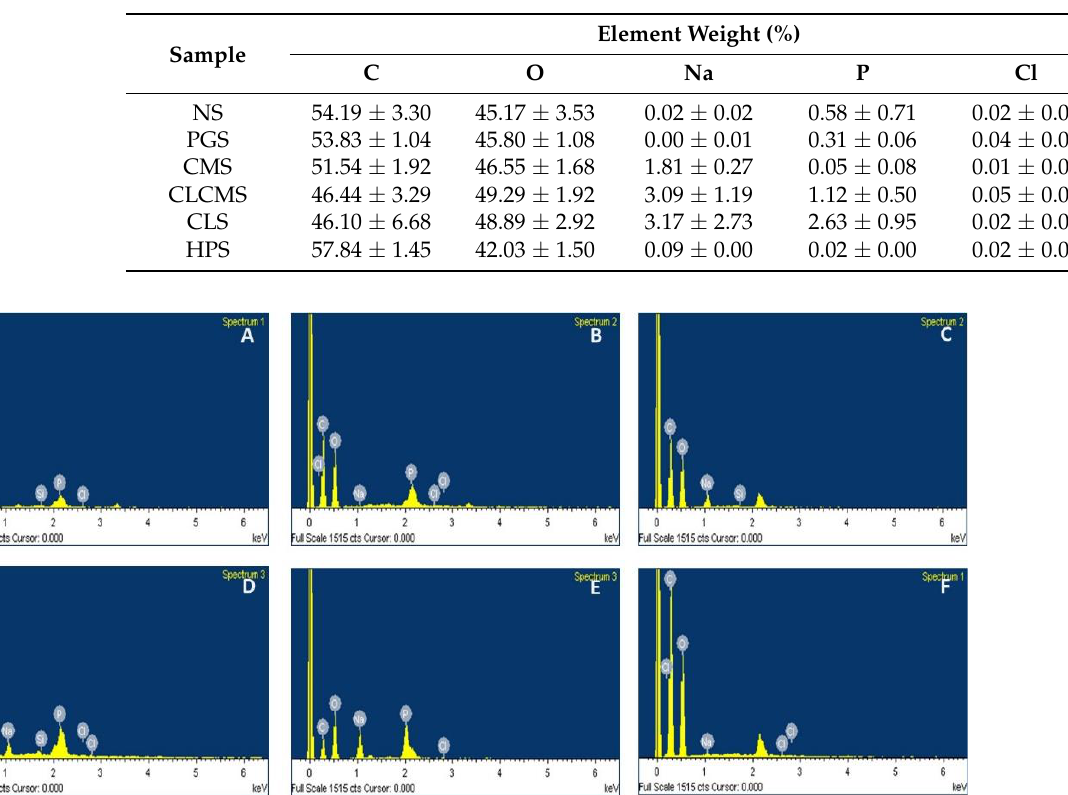
Figure 3. EDX Spectra of ( A ) NS, ( B ) PGS, ( C ) CMS, ( D ) CLCMS, ( E ) CLS, and ( F ) HPS Modified from KJ CMU-107 Rice Starch. Table 1. Energy-dispersive X-ray (EDX) Analysis of Native and Modified KJ CMU-107 Starches.